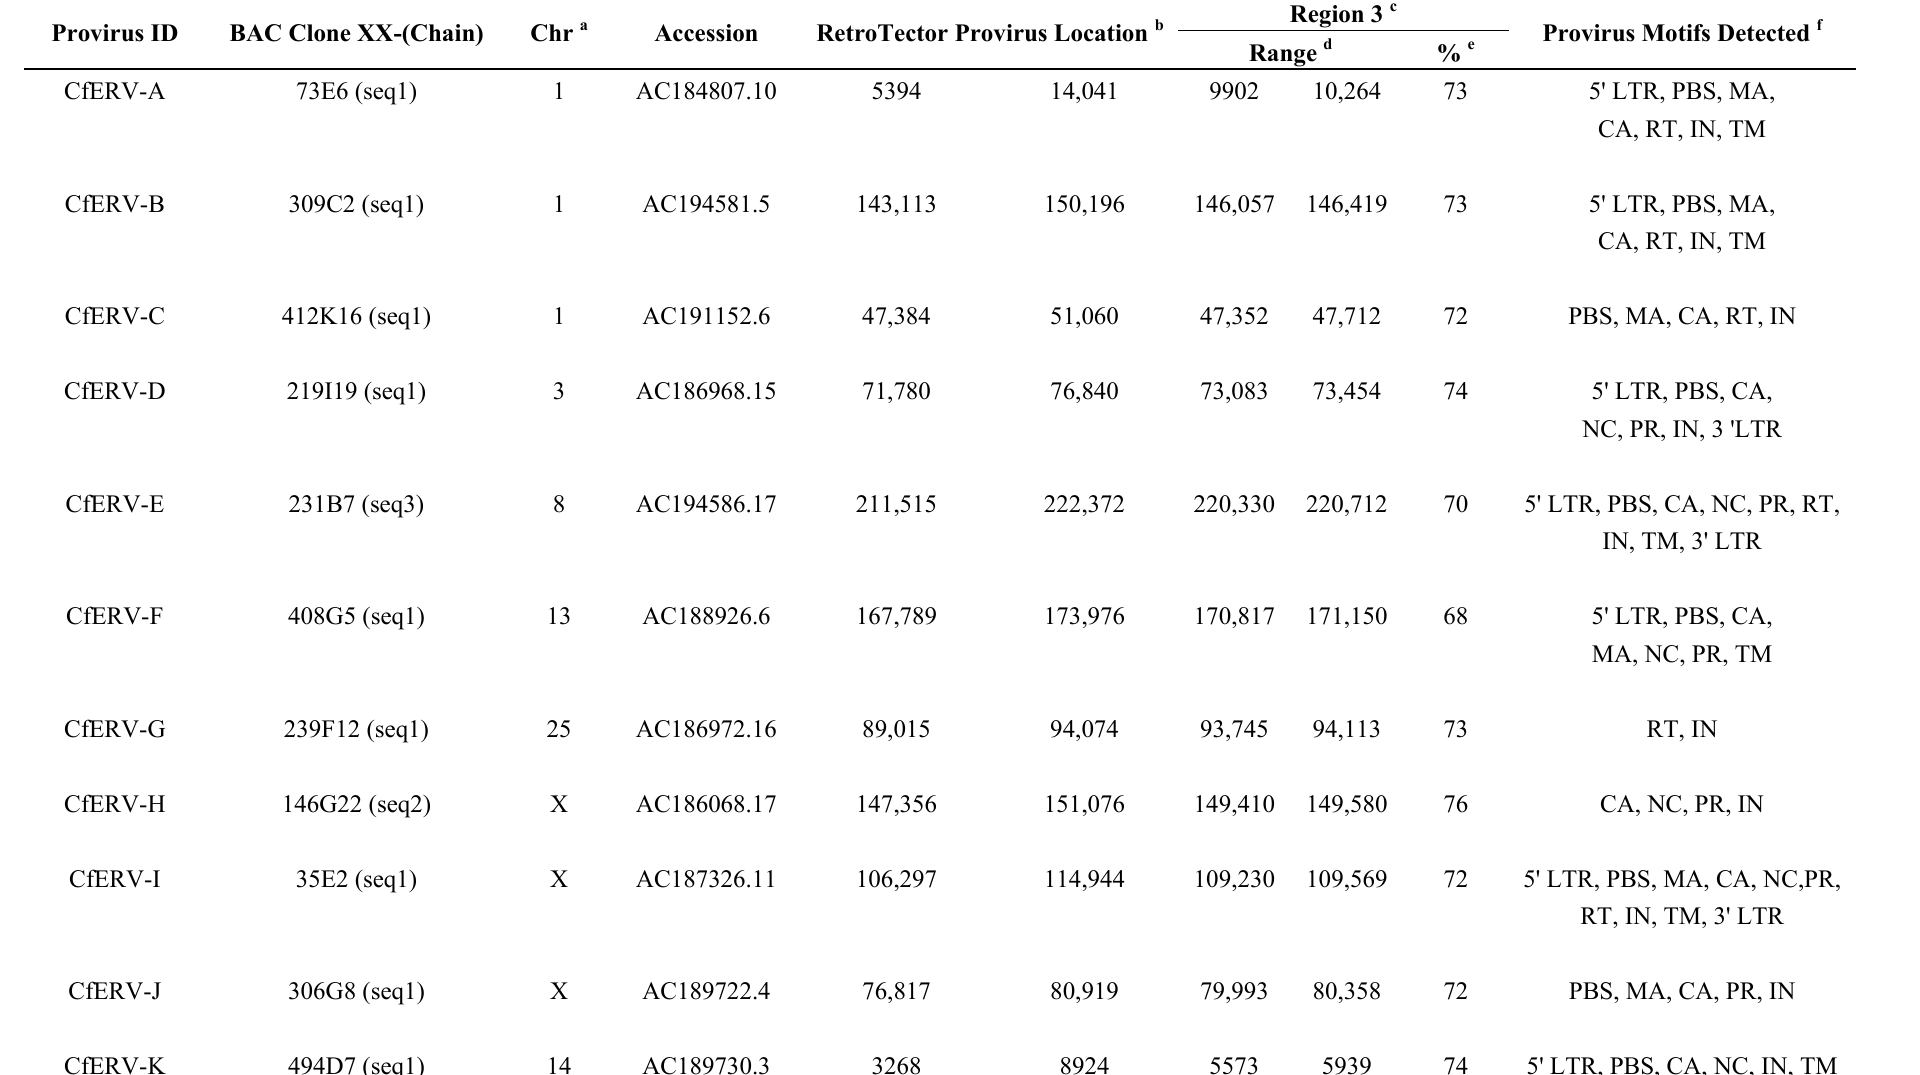
Table 4. Proviral regions within the Canis familiaris BAC clones detected by